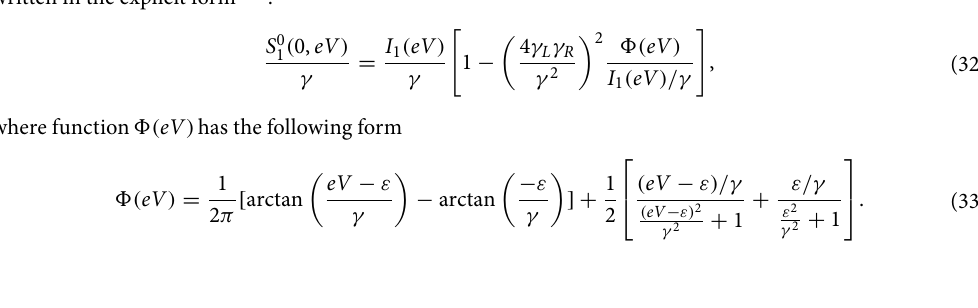
Table 1. Currents and noise maximum values as a functions of contact asymmetry.